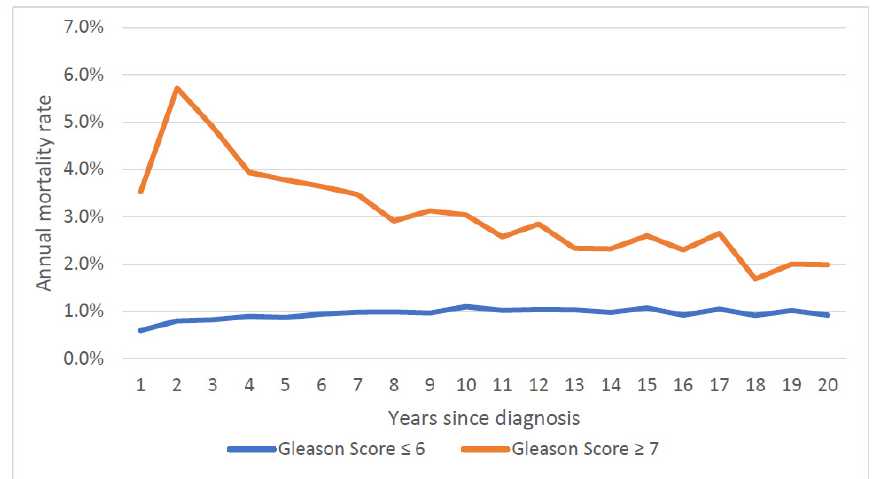
Figure 2. Annual prostate specific mortality rate, by Gleason score.